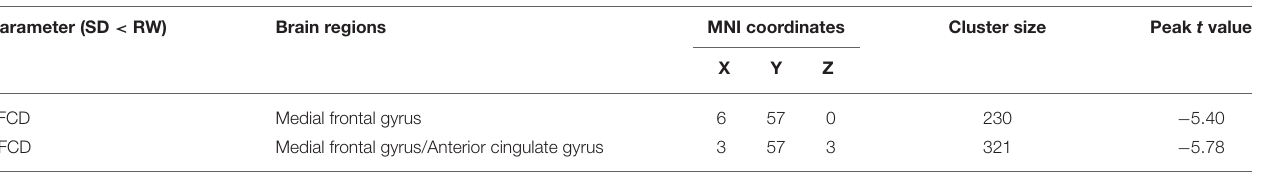
TABLE 2 | Significant differences of FCDs within subjects between RW and SD.